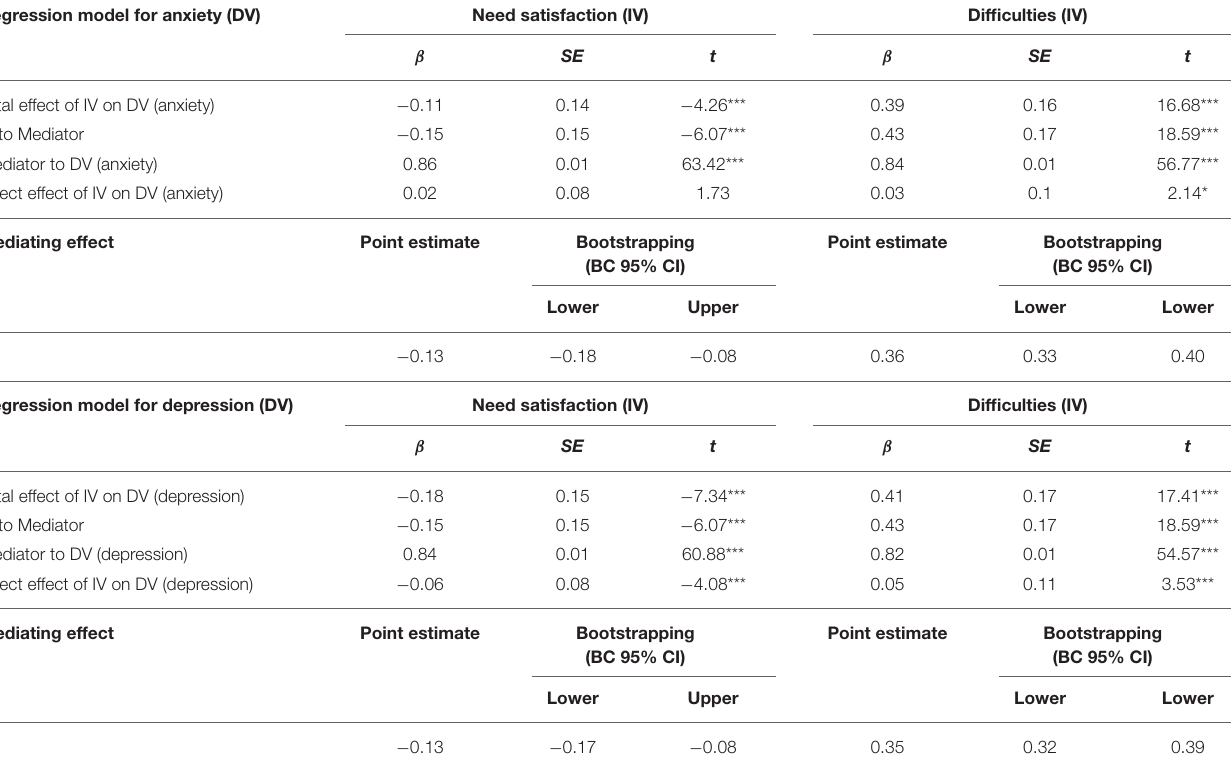
TABLE 5 | Mediating effects of stress (Mediator) for the effect of need satisfaction and difficulties (IV) on anxiety and depression (DV). Regression model for anxiety